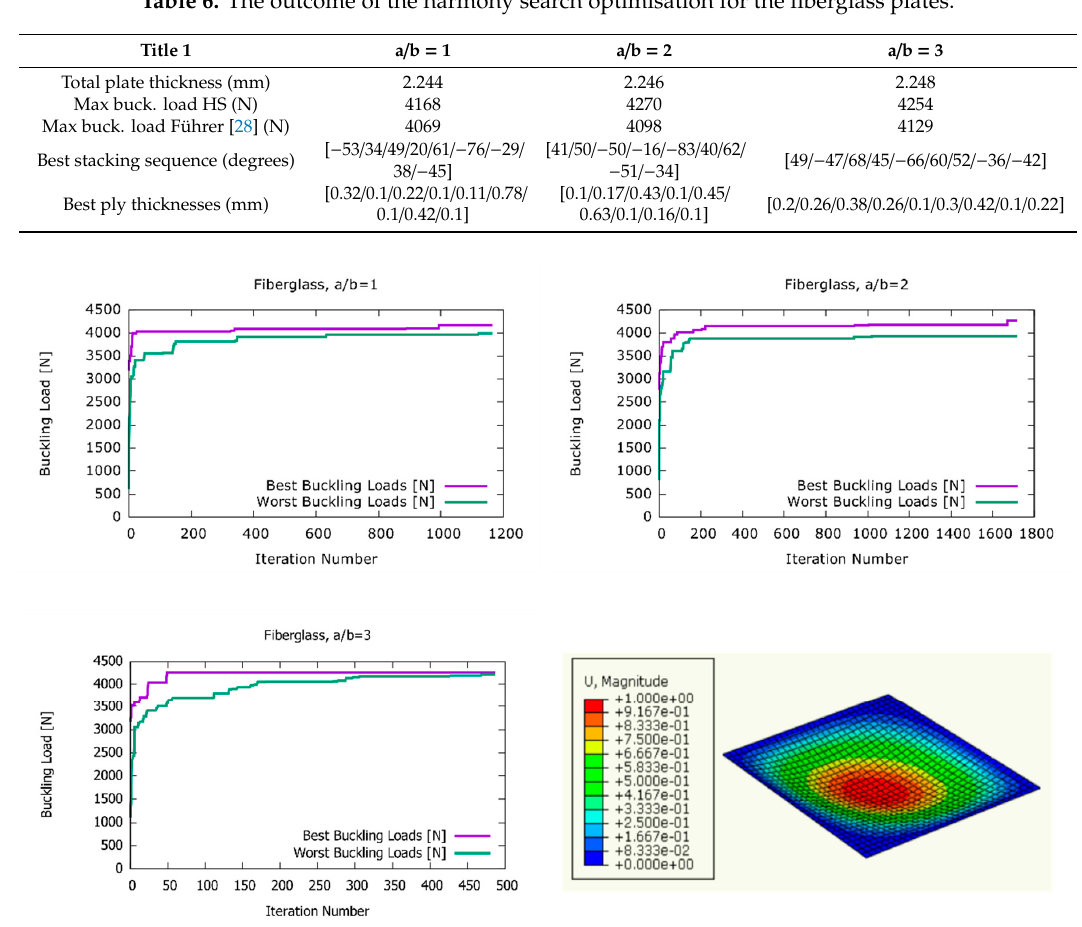
Figure 5. The development of the best and worst solutions in the harmony search optimisation for fiberglass plates.